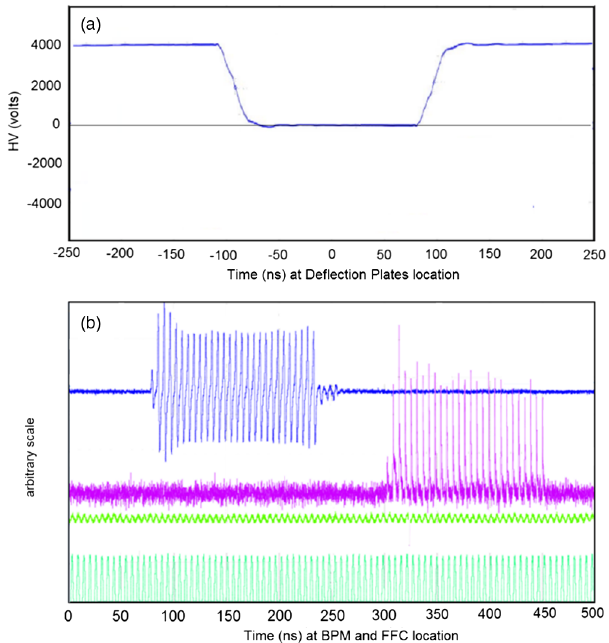
FIG. 2. Slow chopper operation: (a) HV on deflection plates — constant HV of 4 kV for beam deflection with application of 180 ns pulse of reverse polarity for neutralizing the deflection field and allowing momentary transmitting of beam pulse. (b) Oscilloscope trace of beam induced signals on detectors. Green trace is main rf, blue trace is signal induced on the BPM situated in the MEBT, and purple trace is induced signal on the FFC situated 4 meters